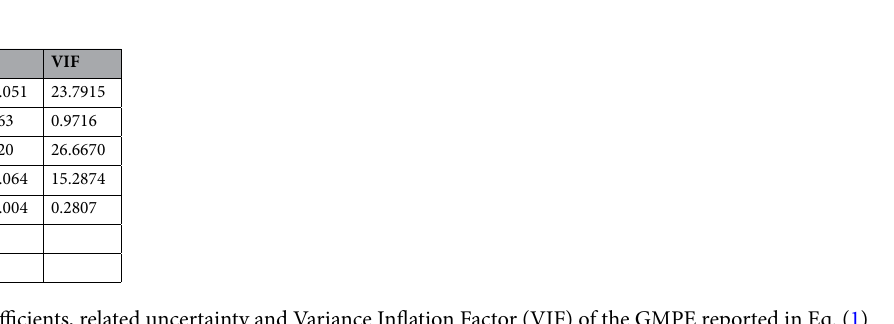
Table 1. Coefficients, related uncertainty and Variance Inflation Factor (VIF) of the GMPE reported in Eq. (1) for The Geysers.